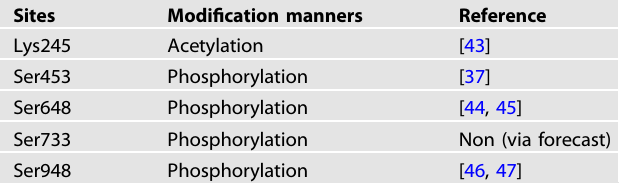
Table 2. The modi fi cation sites of